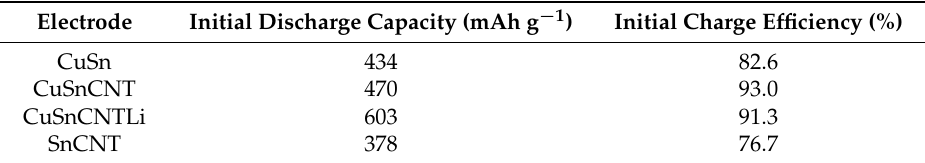
Table 3. Performance characteristics of the